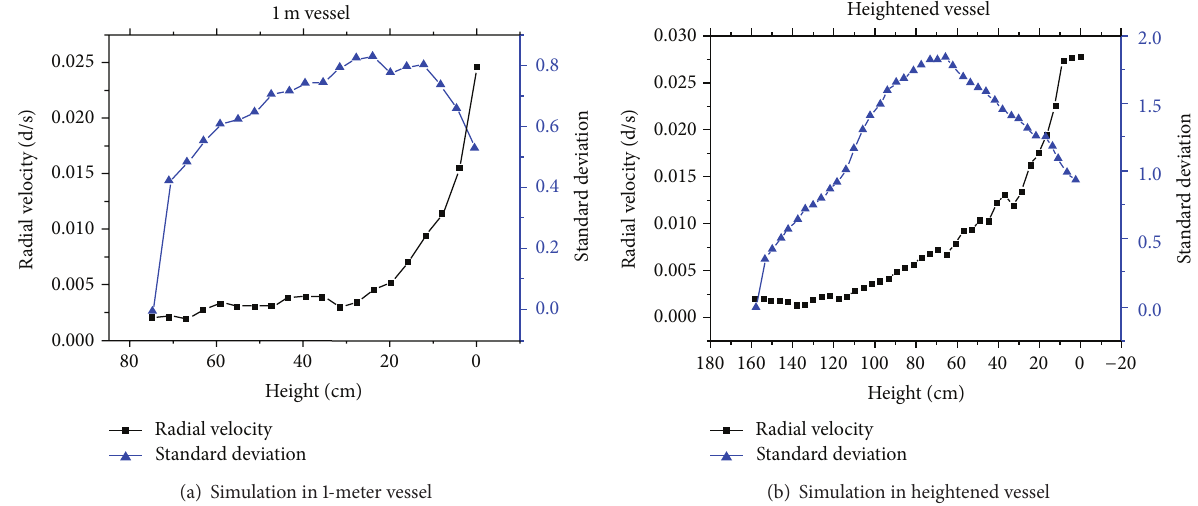
Figure 9: DEM simulations on standard deviation and radial velocity in 1-meter and heightened vessels.